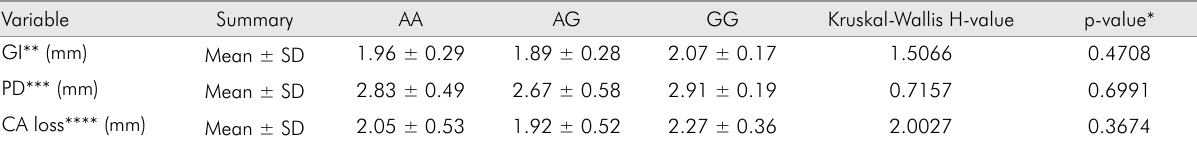
Table 2. Comparison of genotypes in respect to different variables for chronic periodontitis patients according to Kruskal-Wallis one way ANOVA.